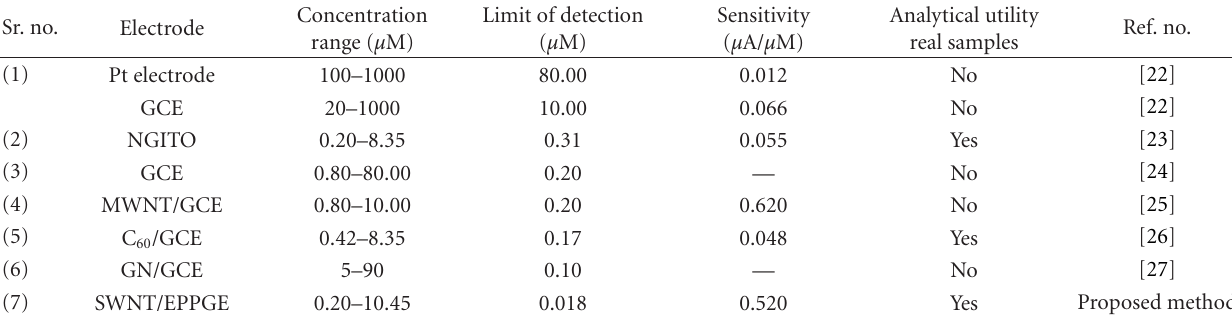
Table 3: A comparison of voltammetric response of SWNT/EPPGE with previously reported methods for the determination of salbutamol. Sr.